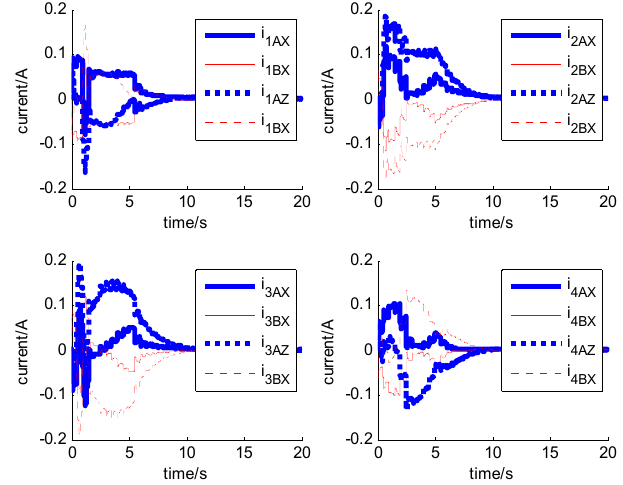
Figure 18. The magnetically suspended rotor control current without feedforward compensation.